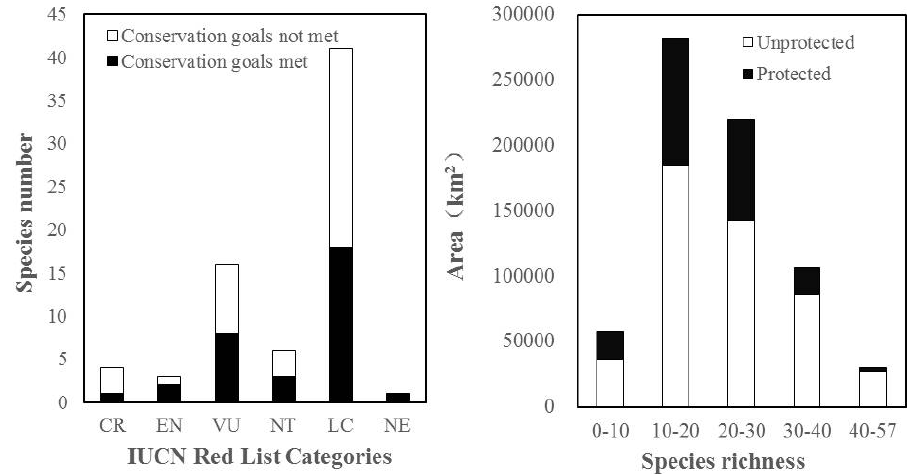
Figure 2. Summary of the conservation gap for key rare and endangered species in Qinghai Province: (a) species number of conservation goals met and not met; (b) the area protected and unprotected in na- ture reserves (CR – Critically Endangered, EN – Endangered, VU – Vulnerable, NT – Near Threatened, LC - Least